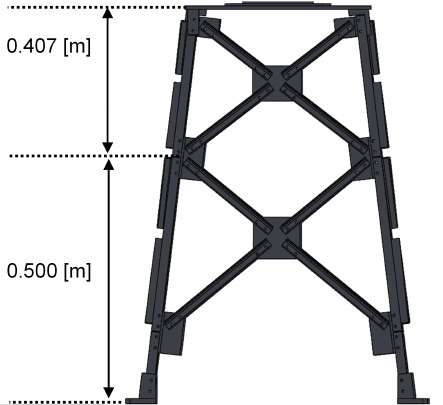
Figure 5. Base of the lab-scale wind turbine jacket